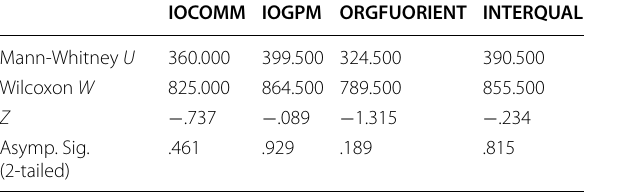
Table 1 Non-response bias